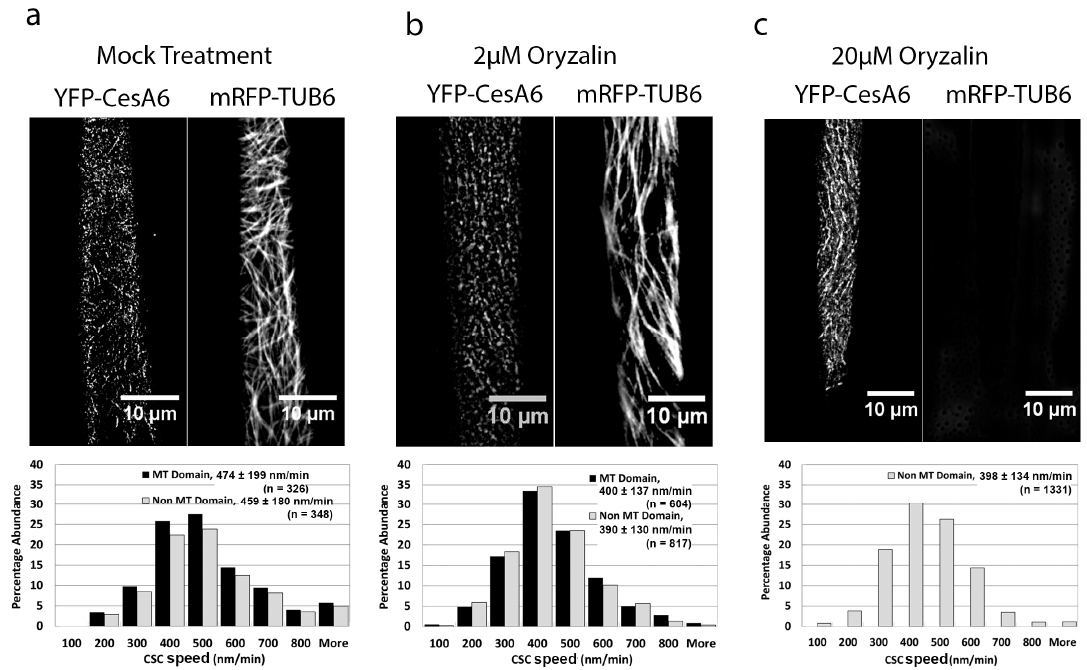
Figure 3. The microtubule-destabilizing drug oryzalin reduces CSC speed. ( a – c ) Projections of 5-min time-lapse images of YFP-CesA6 and mRFP-TUB6, and CSC speed distribution in microtubule and non-microtubule domains in wild type after 3 h treatments with 0.1% DMSO (mock) ( a ), 2 μ M oryzalin/0.1% DMSO ( b ), and 20 μ M oryzalin/0.1% DMSO ( c ). Values are means ± SD. CSC speed in oryzalin-treated seedlings was significantly reduced compared to that of mock treatment ( p < 0.0001). There was no significant difference in mean CSC speed between microtubule and non-microtubule domains in mock and oryzalin treatments. All samples were incubated at 29 ◦ C. See also Movies